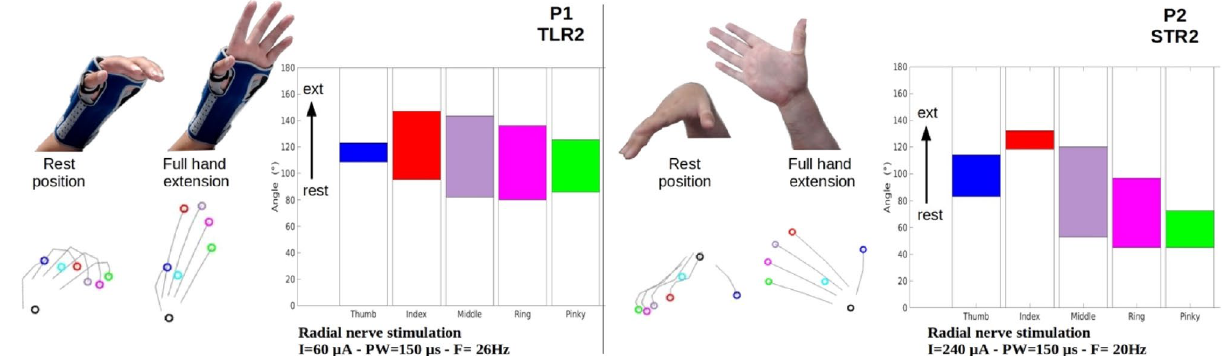
Figure 3. Kinematics data of hand opening. Left: participant P1—Radial nerve stimulation TLR2 (Wrist brace + Thumb splint). Right: participant P2—Radial nerve stimulation STR2 (Thumb splint). Video snapshots and posture reconstruction based on Leap Motion data. The diagrams represent the excursions of the 5